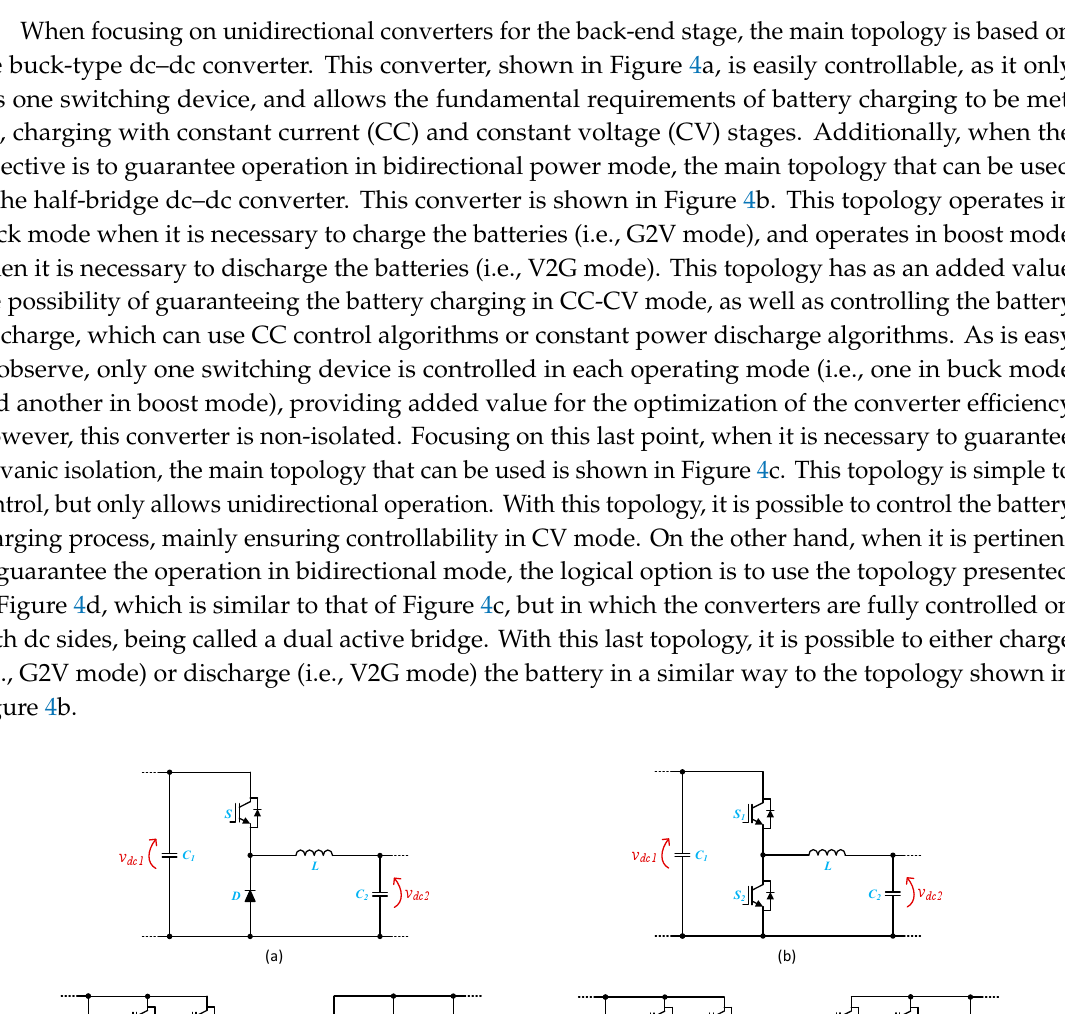
Figure 3. Main single-phase power electronics converters used as front-end power stage of on-board electric vehicle battery-charging system (EVBC): ( a ) unidirectional power factor correction; ( b )